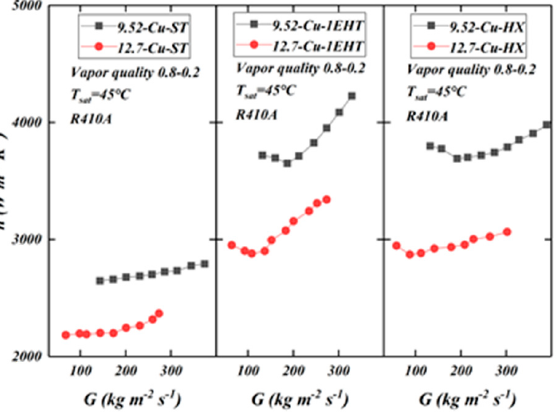
Figure 10. Comparison of HTC (as a function of mass flow rate) for different diameter (9.52 and 12.7 mm) tubes produced from copper, for smooth (ST) and enhanced (1EHT and HX)